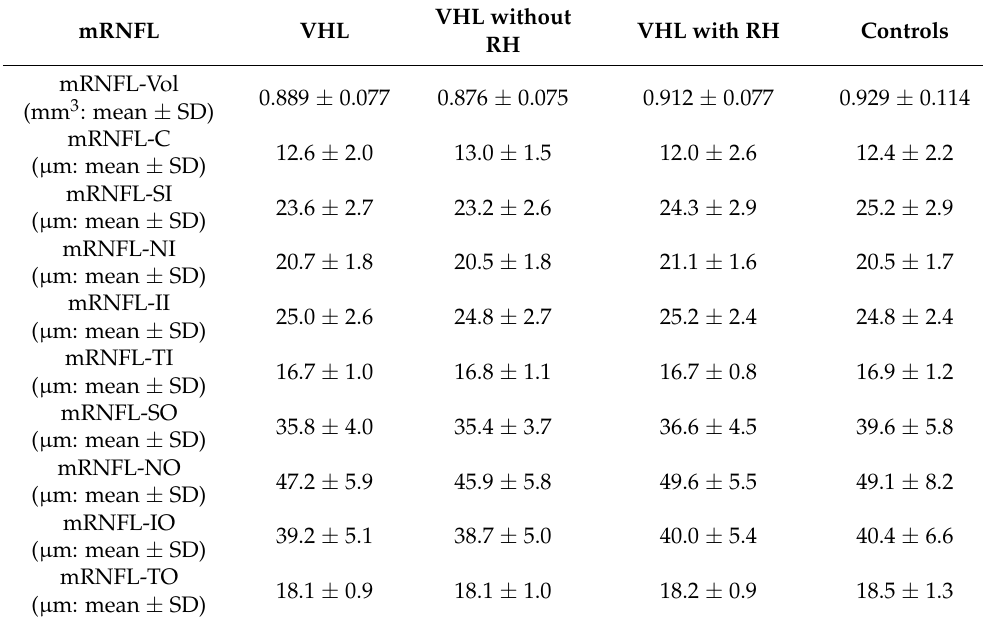
Table 4. Volume and thickness of mRNFL in the analyzed groups.